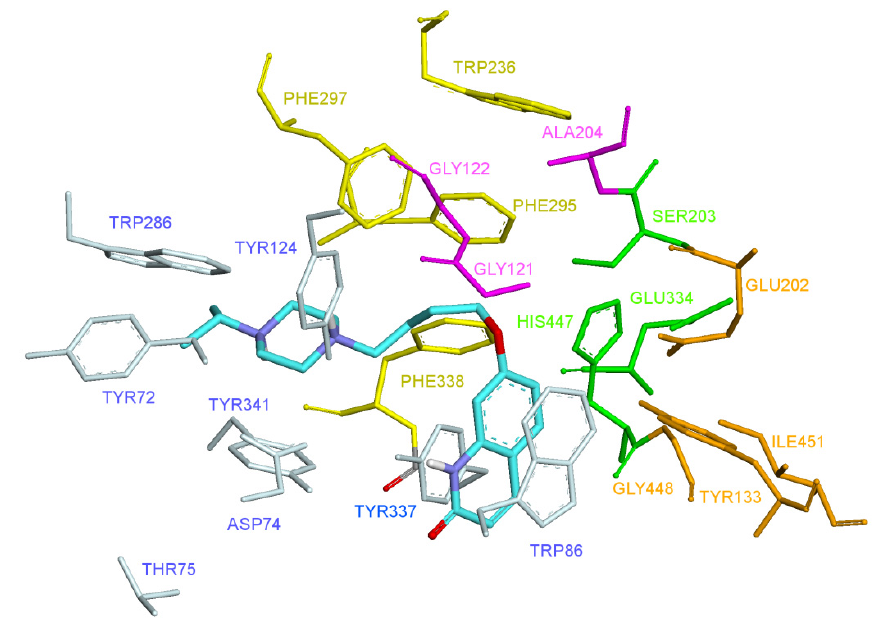
Figure 7. Binding mode of QN8 in the active site of hr AChE. Compound QN8 is rendered as sticks (carbon atoms in blue) and the side chain conformations of the mobile residues are illustrated in light blue. Catalytic triad (CT) is coloured in green, oxyanion hole (OH) in magenta, anionic subsite (AS) in orange except Trp86, the acyl binding pocket (ABP) in yellow, and peripheral anionic site (PAS) in light blue.